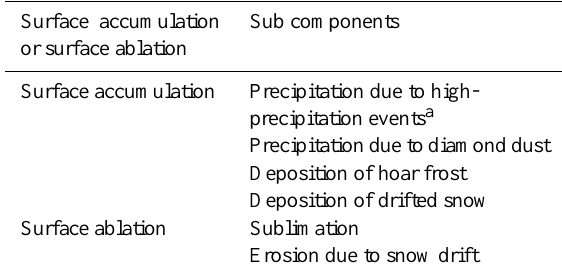
Table 5. Components of surface mass